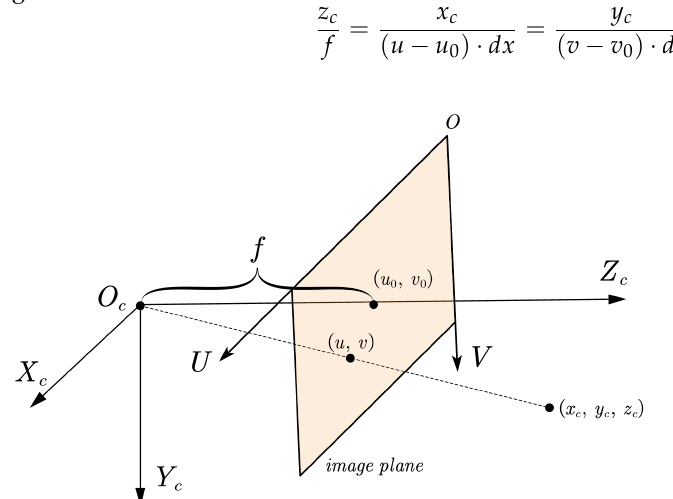
Figure 1. The intrinsic camera